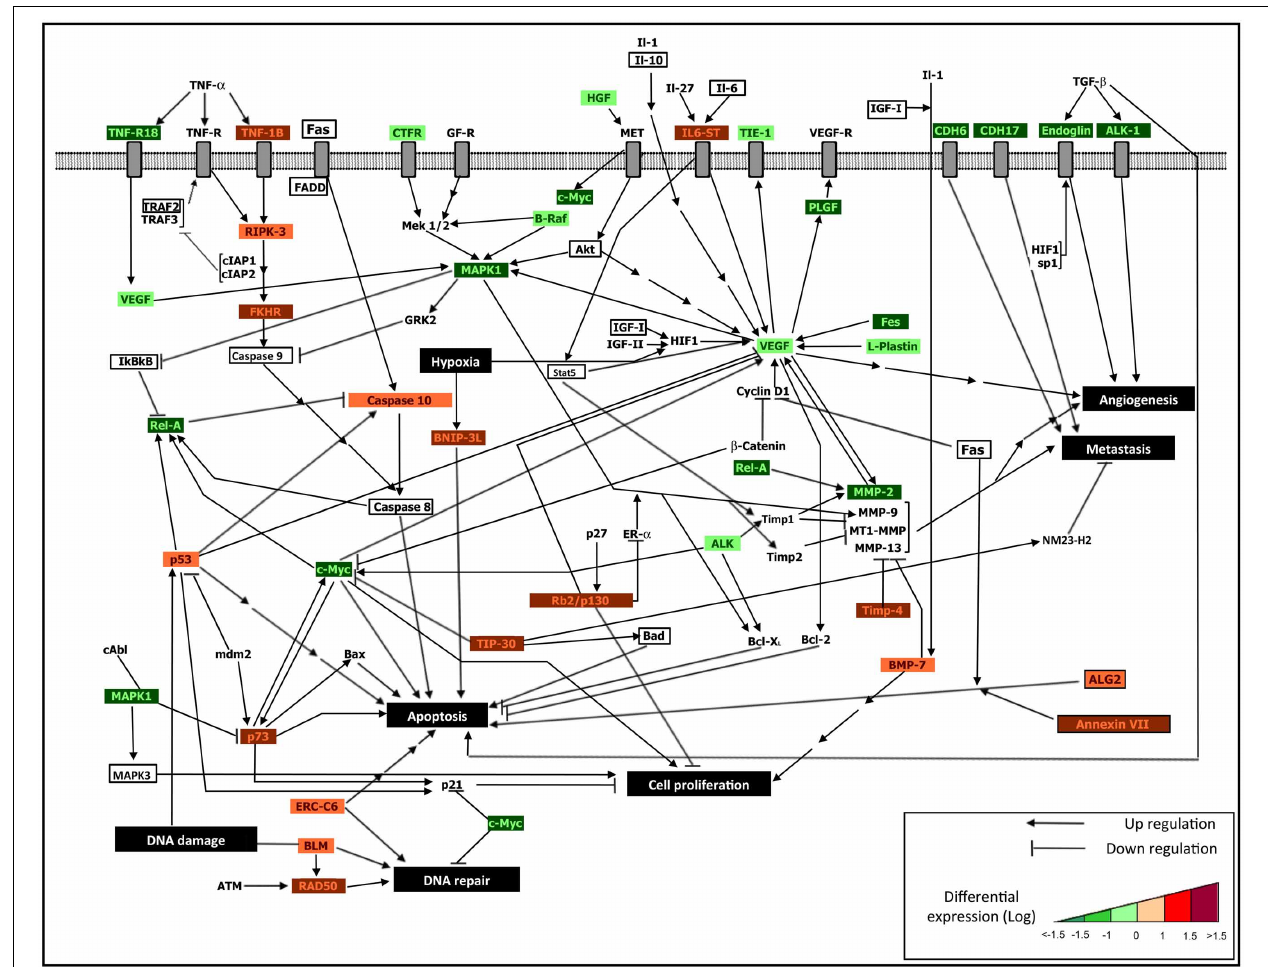
FIGURE 1 | An integrative regulatory map. Integrated interactomic relationships are presented, starting from the DE genes derived from the cDNA microarray analysis, and considering connectivity with non-DE genes (marked in bold font) obtained from the reported network extension and functional enrichment tools. The non-DE genes excluded from the experiments (labeled without colors) allow to establish systems relationships with DE genes (down-regulated after treatment, which appear in green frame, and up-regulated after treatment, which appear in red frame), and to highlight the biological influence of epigenetic treatments. We identified major influences in terms of: activation of osteoblast differentiation and apoptotic signaling, and inhibition of cell proliferation, metastasis and angiogenesis. In particular, following the described treatments, the re-expression of epigenetically silenced key genes re-establishes cellular homeostasis throughout mechanisms such as: 1. Osteoblast differentiation